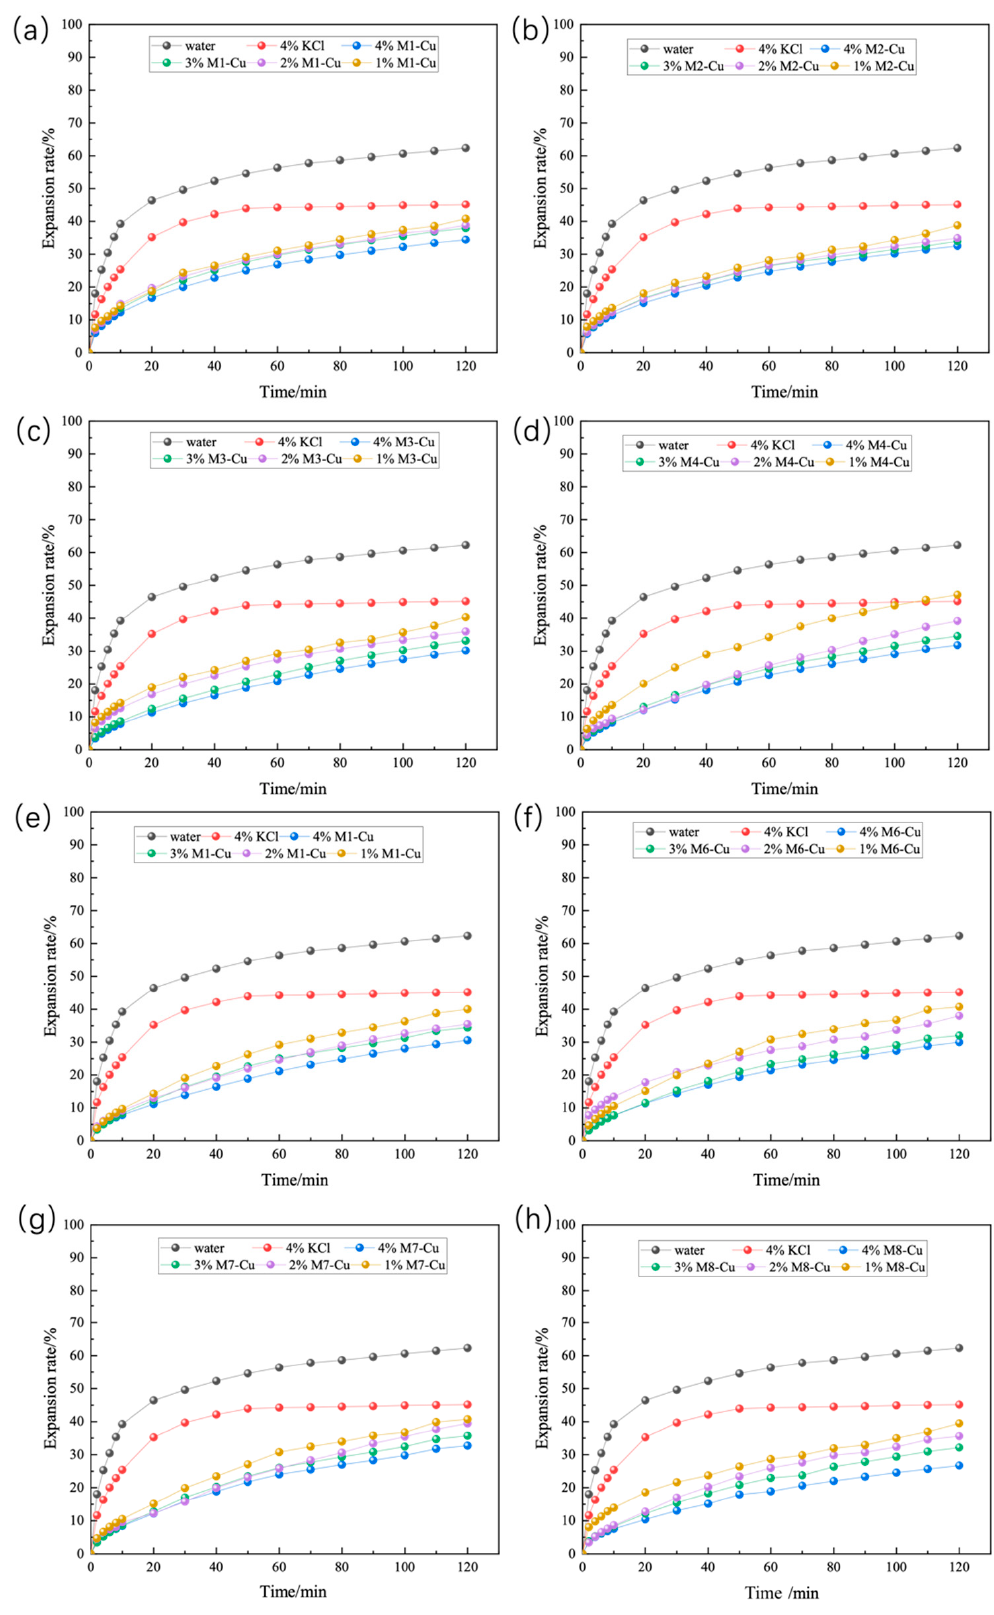
Figure 2. Linear expansion of Cu-doped MMH with different concentrations (( a ): M1-Cu; ( b ): M2-Cu; ( c ): M3-Cu; ( d ): M4-Cu; ( e ): M5-Cu; ( f ): M6-Cu; ( g ): M7-Cu; ( h ): M8-Cu).